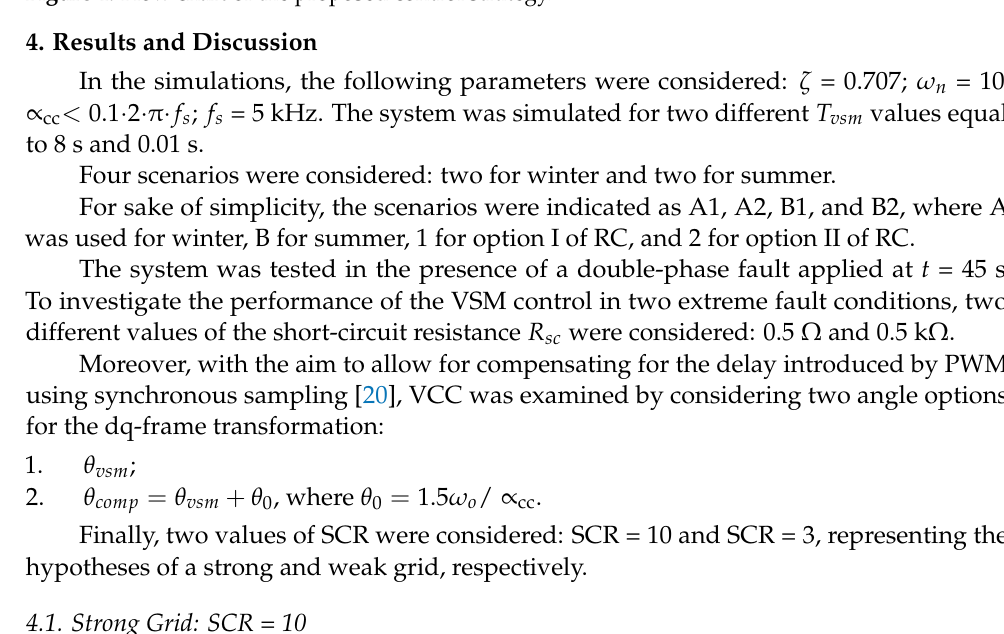
Figure 4. Flow chart of the proposed control